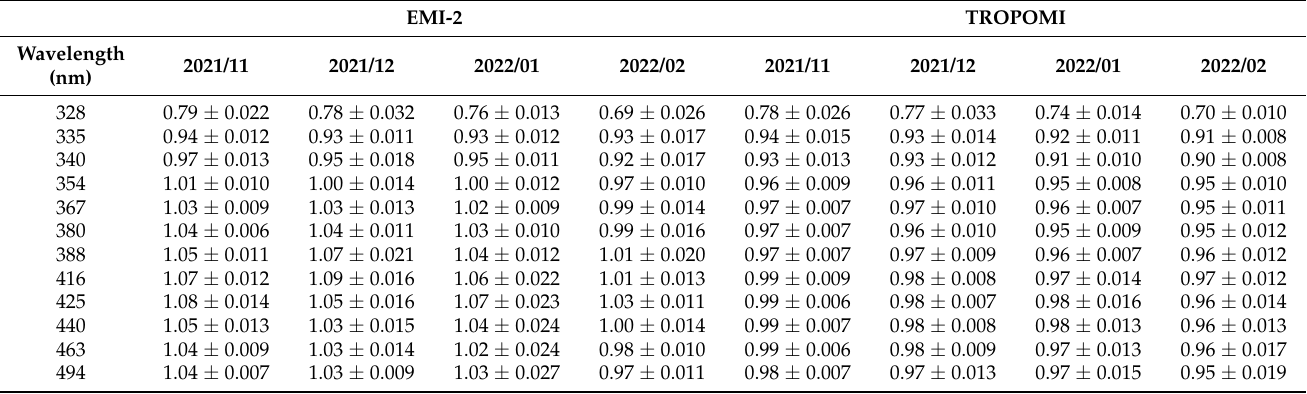
Table 3. The mean and standard deviation of the monthly atmospheric transmission correction factor of EMI and TROPOMI at different wavelengths.